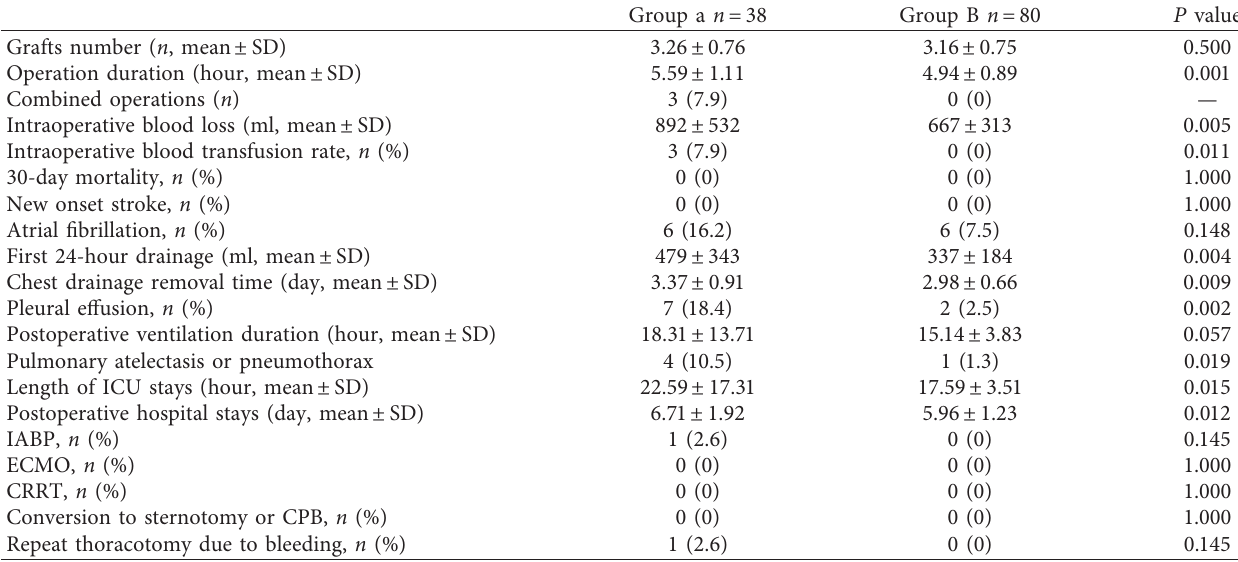
Table 4: Surgical information and clinical outcomes.